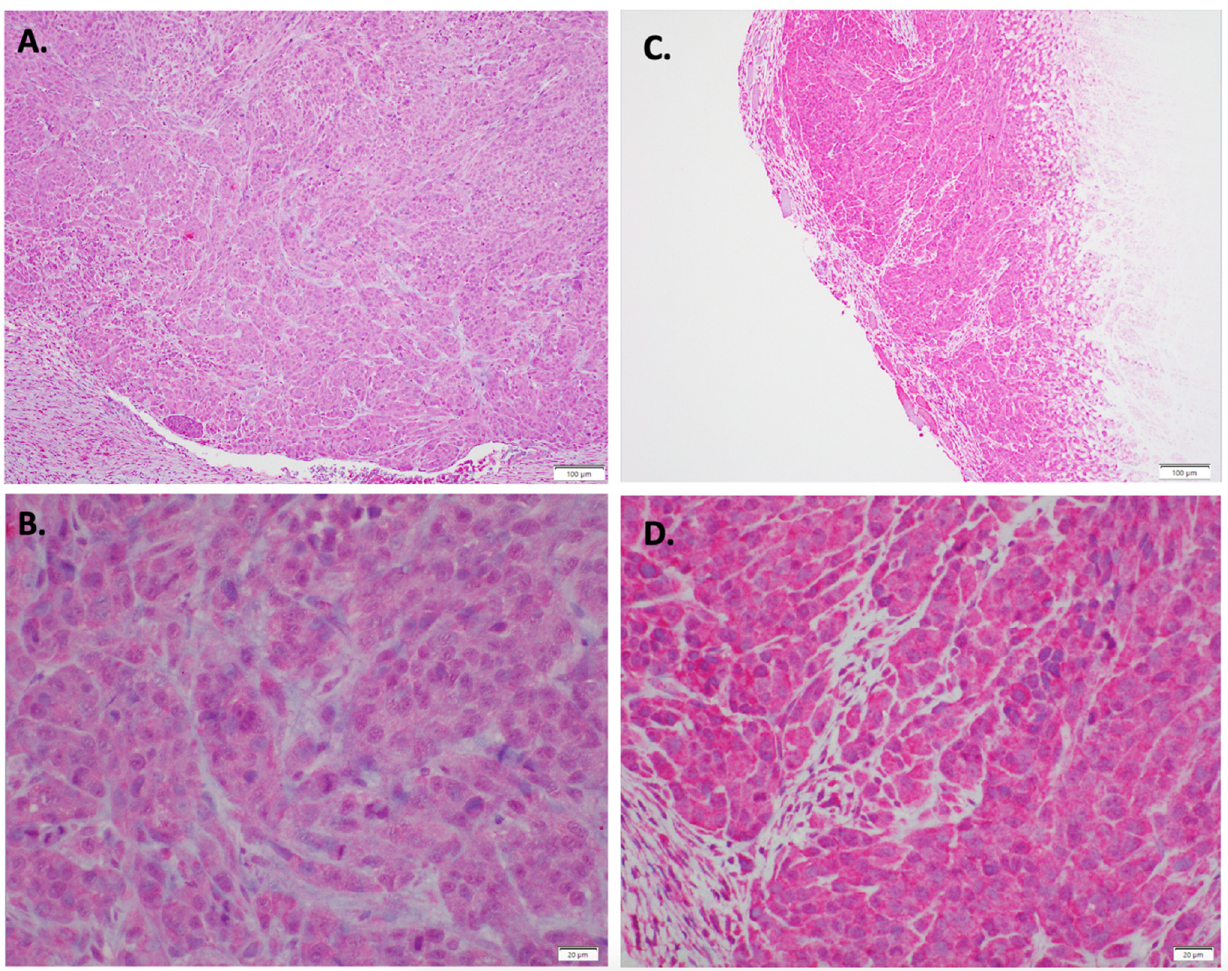
Figure 5. Immunohistochemical staining Nkx3.2 staining with ( A ) Control (10×) ( B ) Control (40×) ( C ) Indolium 1 Treatment (10×) ( D ) Indolium 1 Treatment (40×). Note increased Nkx3.2 staining in treated tumors ( C , D ).